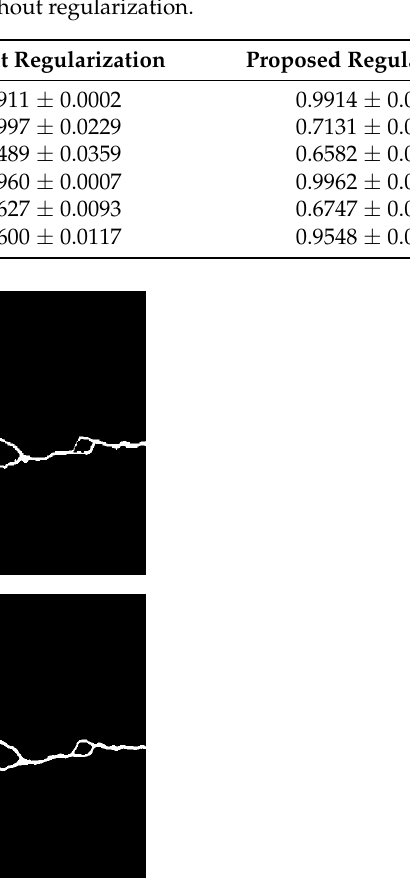
Figure 6. An example of the crack images. ( Top left ) image. ( Top right ) ground truth. ( Bottom left ) without regularization. ( Bottom right ) with proposed regularization.